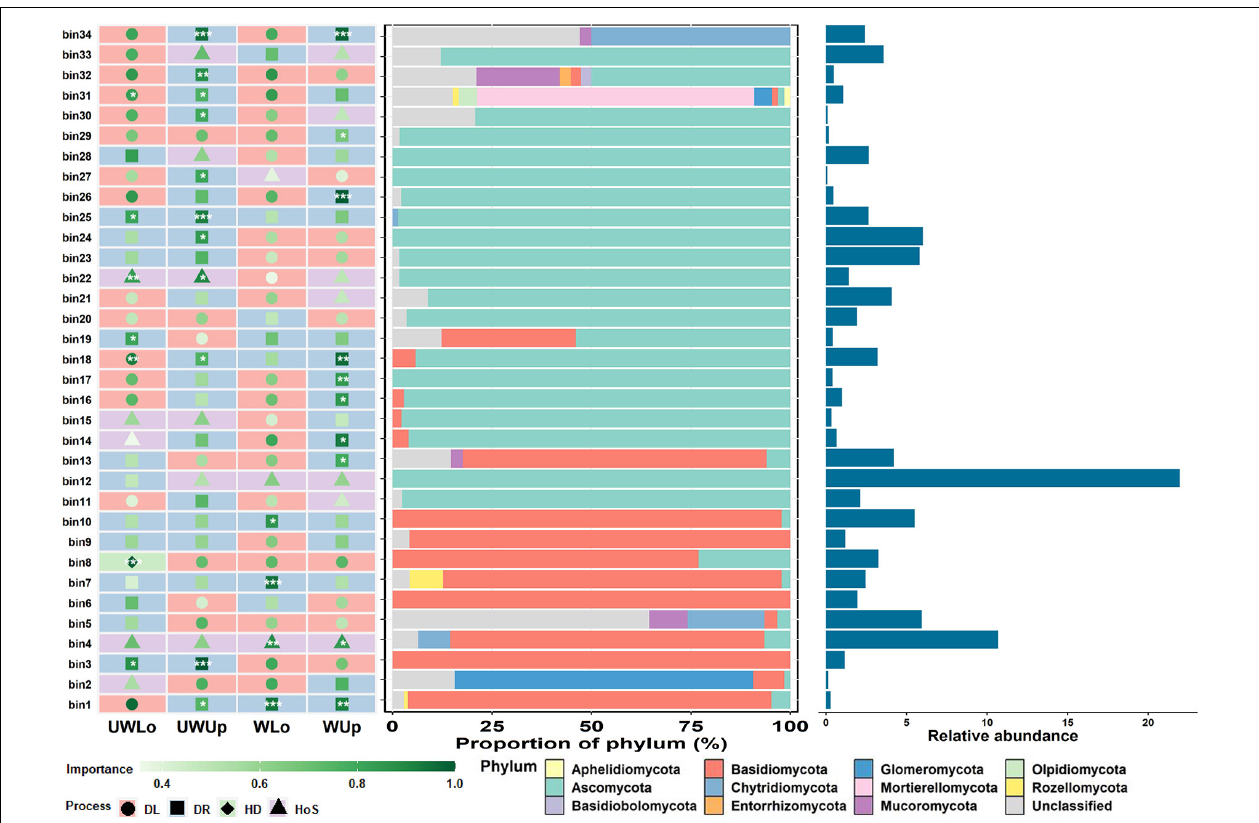
FIGURE 3 | The importance of each phylogenetic bin of the fungal community with associated taxa composition and relative abundance. *** p < 0.001, ** p < 0.01, * p < 0.05, showed the significance of the dominating process in each bin based on 1000 bootstrapping times. UWUp, unwarming upper; UWLo, unwarming lower; WUp, warming upper; WLo, warming lower; DL, dispersal limitation; DR, undominated; HD, homogeneous dispersal; HoS, homogeneous